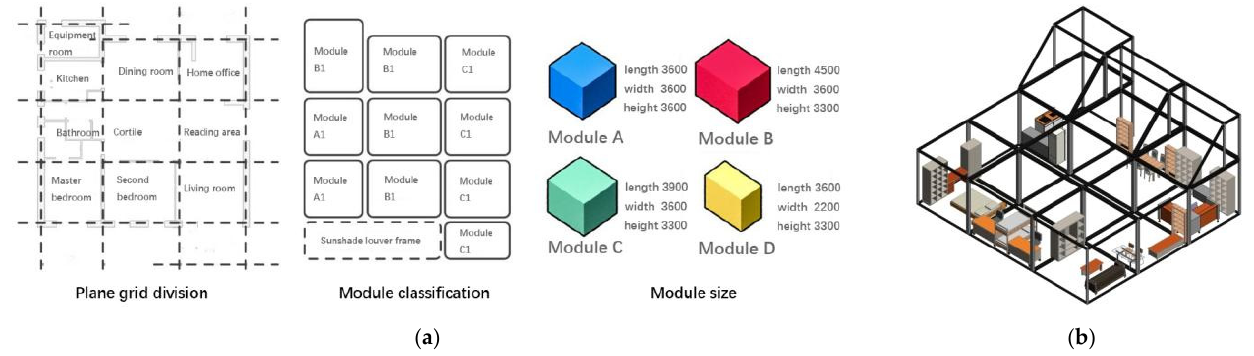
Figure 11. Module division form and BIM model for modular design. ( a ) Module division form; ( b ) modular BIM module.